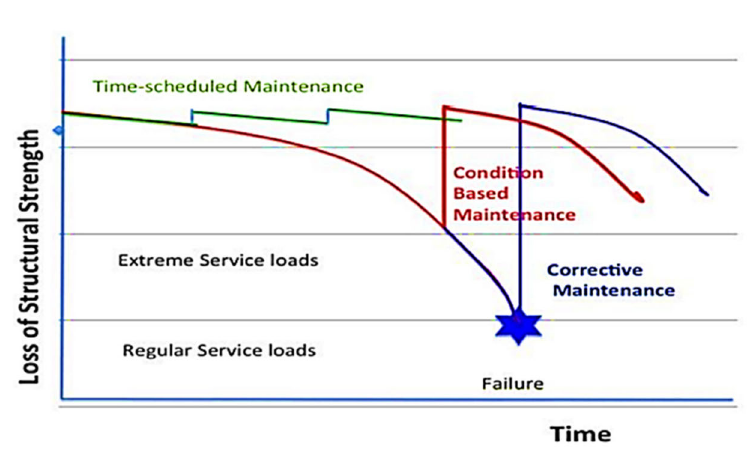
Figure 2. Maintenance strategies with/without SHM [3].